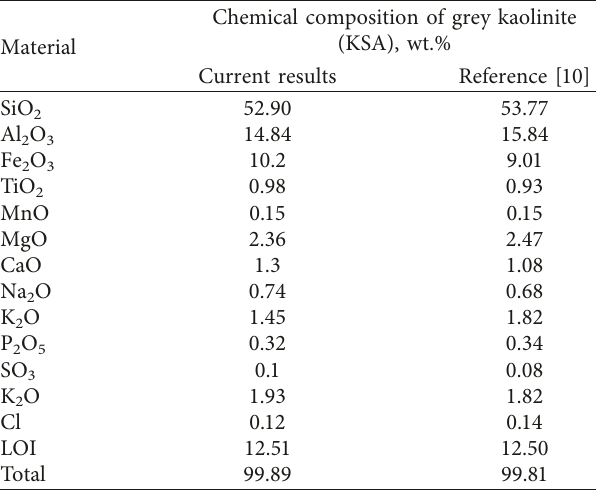
Table 2: Chemical composition of analyzed Saudi grey clay.